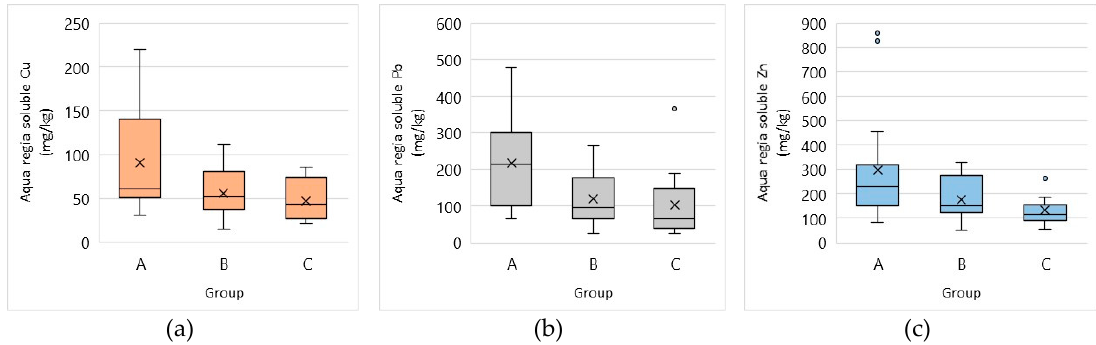
Figure 2. Variation in concentrations of copper ( a ), lead ( b ) and zinc ( c ) with proximity to Glasgow City Centre (A: <10 miles; B: 10–30 miles; C >30